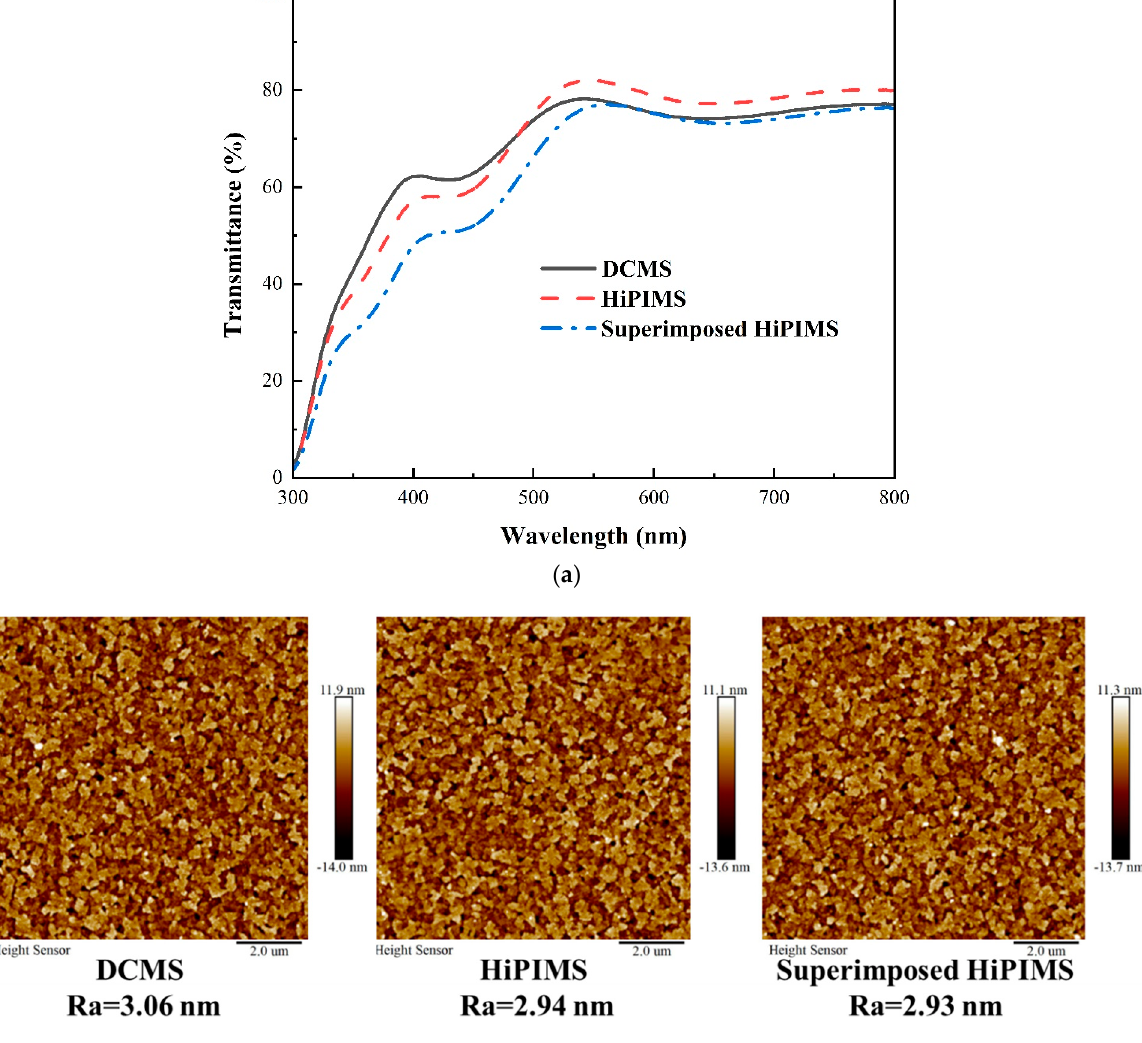
Figure 2. ( a ) UV-Vis spectra and ( b ) AFM topography images of Cu 2 O fi lms deposited using various processes.